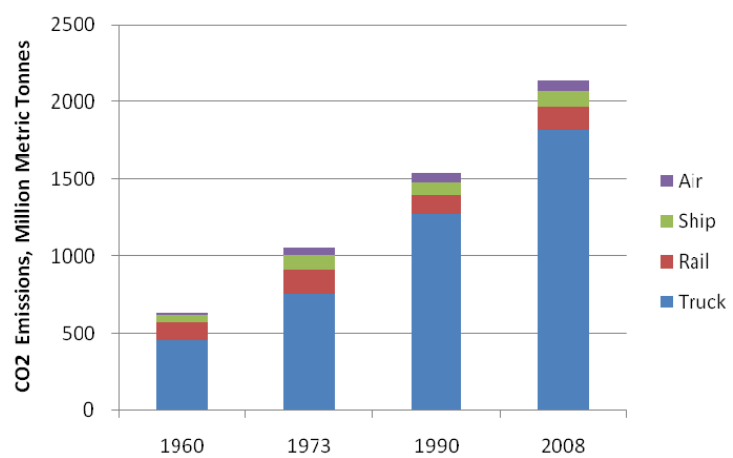
Figure 4. Freight Carbon